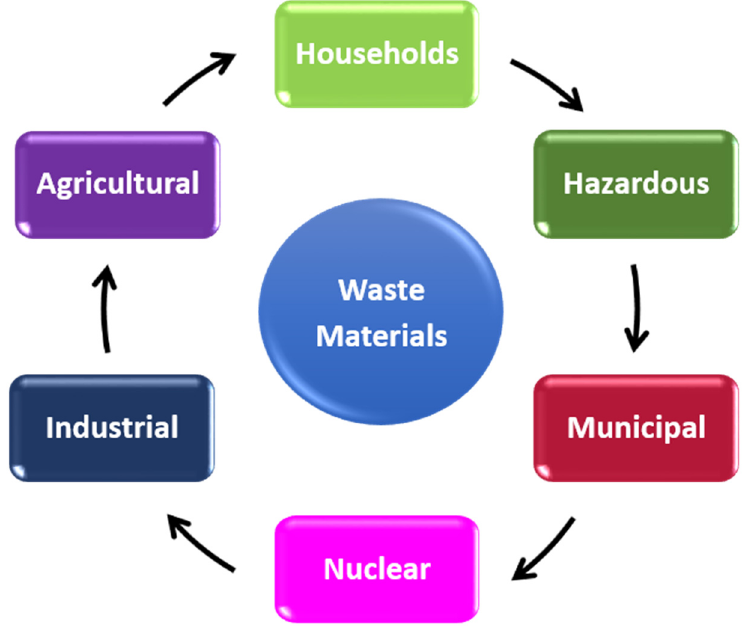
Figure 1. Production of various types of waste.